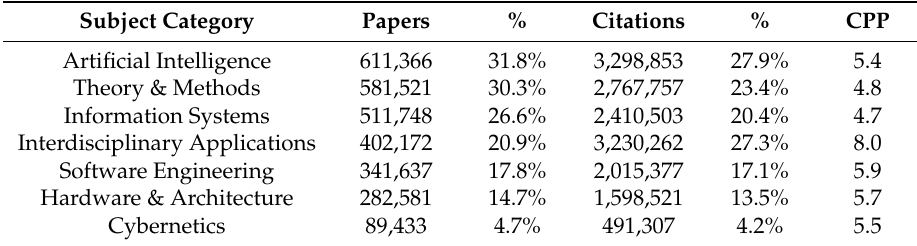
Table 3. Subject categories and their papers, citations, and citations per paper